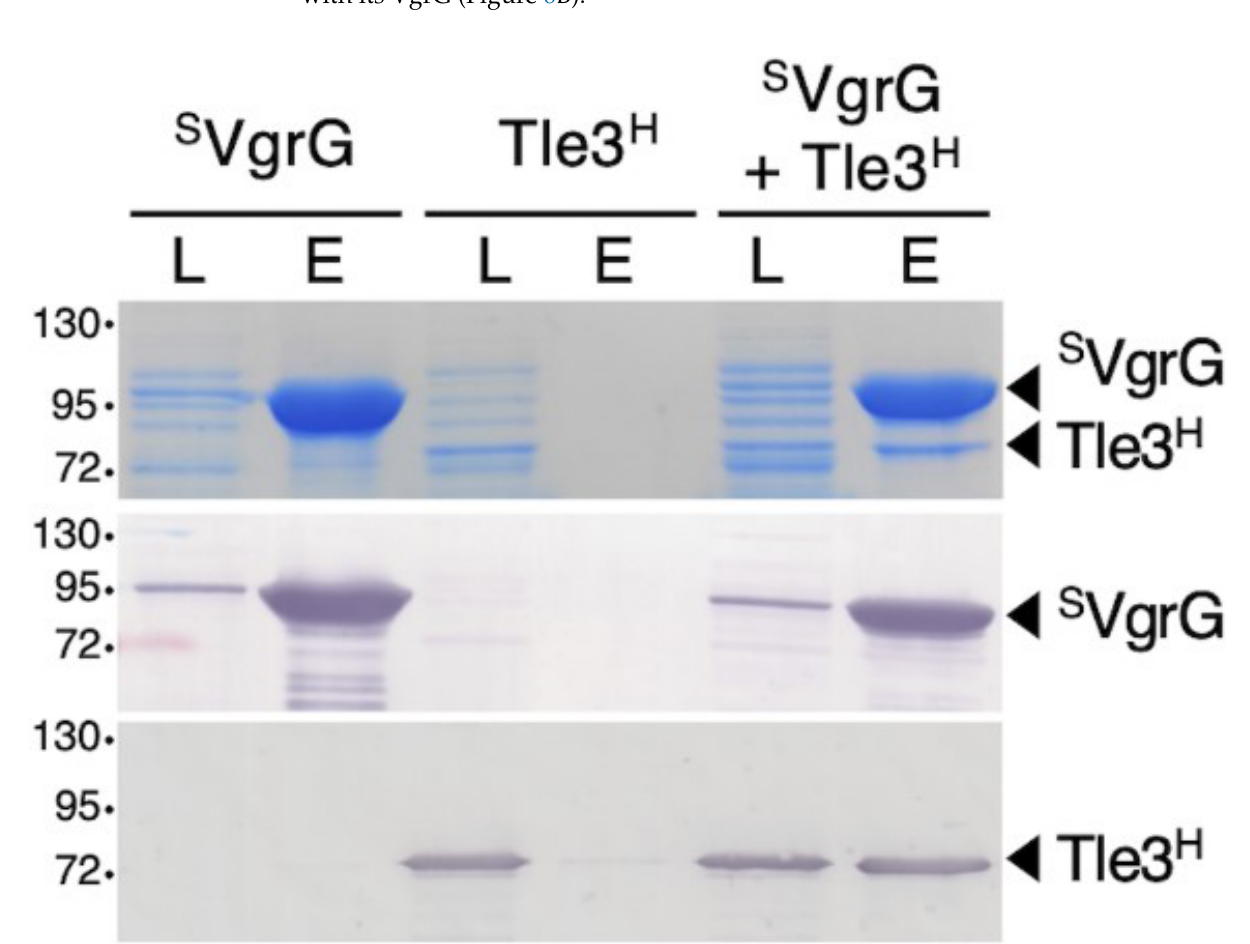
Figure 5. Tle3 AIEC interacts with VgrG AIEC . Strep-tag II-tagged VgrG ( S VgrG) and 6His-tagged Tle3 (Tle3 H ) were produced separately from E. coli BL21 (DE3) pETDuet- S VgrG and BL21 (DE3) pRSF- Tle3 H cells, respectively. Lysates of cells (L) producing S VgrG, Tle3 H or a 1:1 mix of S VgrG and Tle3 H cell lysates ( S VgrG + Tle3 H ) were incubated with Strep-Tactin Sepharose resin. After five washing